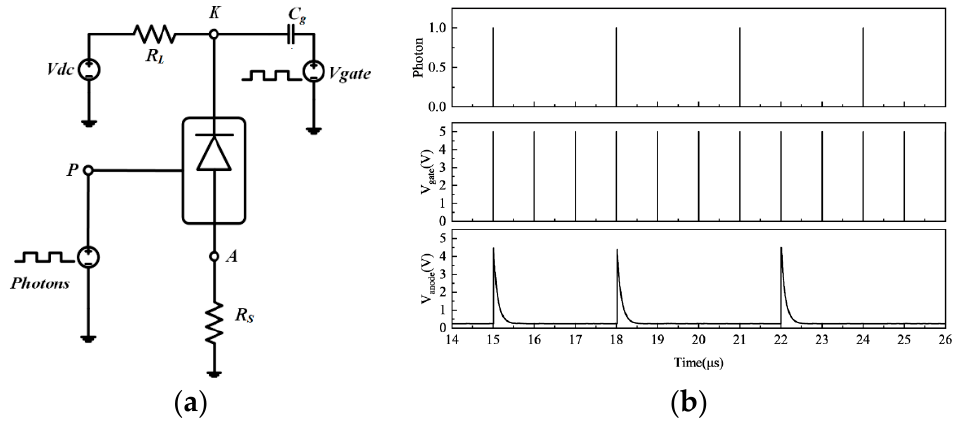
Figure 4. ( a ) A passive quenching-and-recharging circuit (PQRC) applied in an SPAD model simulation.